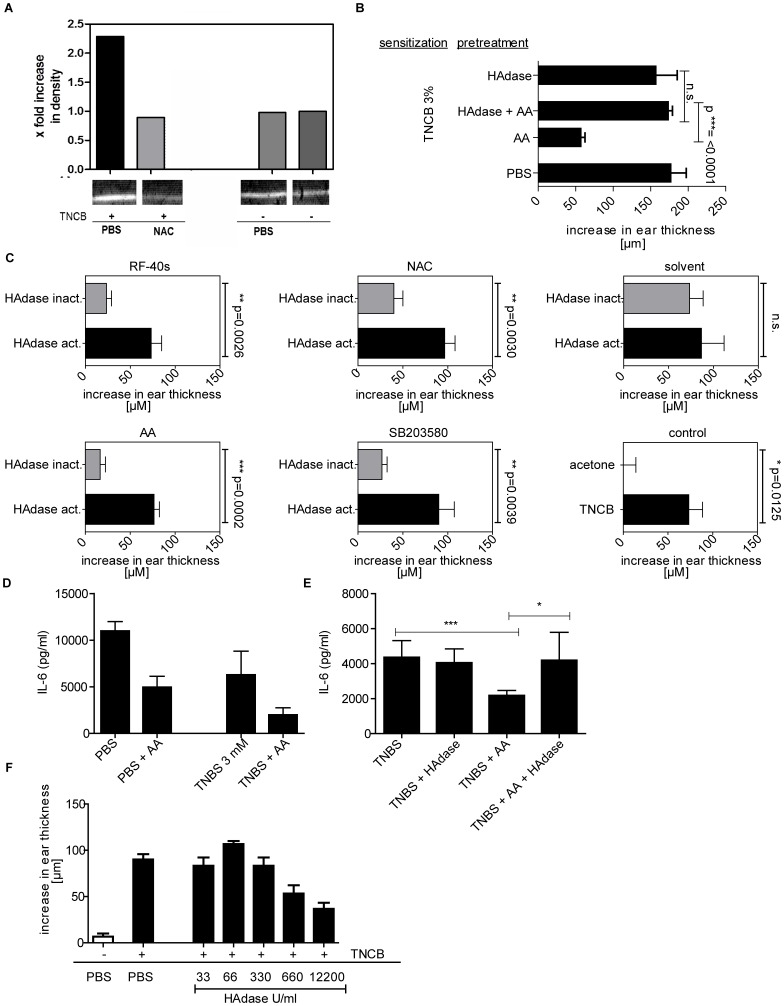
ROS induce increased hyaluronidase activity and blocking hyaluronidases prevents IL-6 production and CHS.(A) The abdomen of mice was topically pre-treated with NAC or PBS before application of TNCB (3%) for 24 h. Hyaluronidase activity was detected by hyaluronidase (HAdase) zymography and fold increase in density over untreated controls from inverted gels is shown as bars. One representative experiment of three is shown. (B) Ears of mice were pre-treated by injection of either PBS as solvent or the hyaluronidase inhibitor aristolochic acid (AA) with or without addition of hyaluronidase (660 U/ml) or hyaluronidase alone. 15 min later, mice were sensitized by topical application of TNCB on the pre-treated ears. 5 days later, ears were challenged by topical application of TNCB. Data show mean increase in ear thickness of groups of three mice +/− SD. One representative of three independent experiments is shown. (C) Ears of mice were topically pre-treated with RF-40s, solvent or NAC or by intracutaneous injection of hyaluronidase inhibitor AA or p38 MAPK inhibitor SB203580 or with acetone (solvent control for TNCB). Indicated groups were additionally injected with active or heat inactivated hyaluronidase. 15 min later, mice were sensitized. Challenged was done 5 days later as in (B). Data show mean increase in ear thickness of groups of three mice +/− SD. One representative of two independent experiments is shown. (D) Ear sheets of C57BL/6 mice were incubated with PBS in combination with AA (50 µM) or with TNBS (3 mM) and AA for 24 h. Samples were analyzed for IL-6 production by ELISA. Data show mean concentrations of IL-6+/− SD of one representative experiment out of two with 9 mice each. (E) Ear sheets of NMRI mice were incubated with TNBS (3 mM) either in combination with hyaluronidase (HAdase; 660 U/ml) or AA (50 µM) or with AA and HAdase for 24 h. Samples were analyzed for IL-6 production by ELISA. Data show mean concentrations of IL-6+/− SD of two independent experiments with n = 3 mice each. (F) Mice were pre-treated by injection of PBS or different concentrations of hyaluronidase (HAdase) into the ear pinna. Afterwards ears were treated with TNCB (3%) for sensitization and increase in ear thickness was measured 5 days later after challenge with TNCB (1%) for 24 h. Data show mean +/− SD of n = 3 mice.